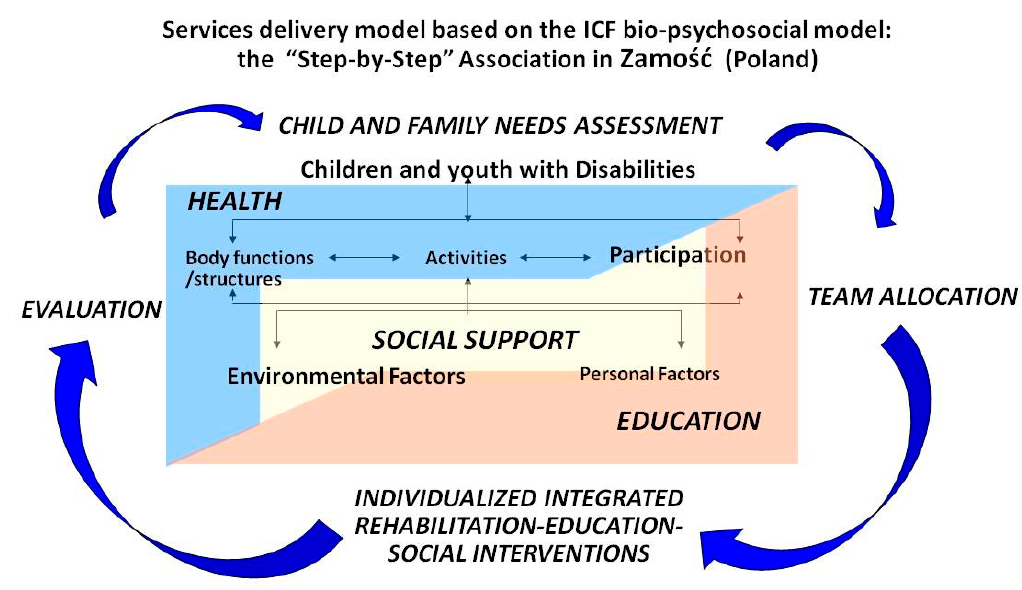
Figure 5. Service delivery model based on the ICF bio-psychosocial model at the Step by Step Association for help of disabled children in Zamo ść